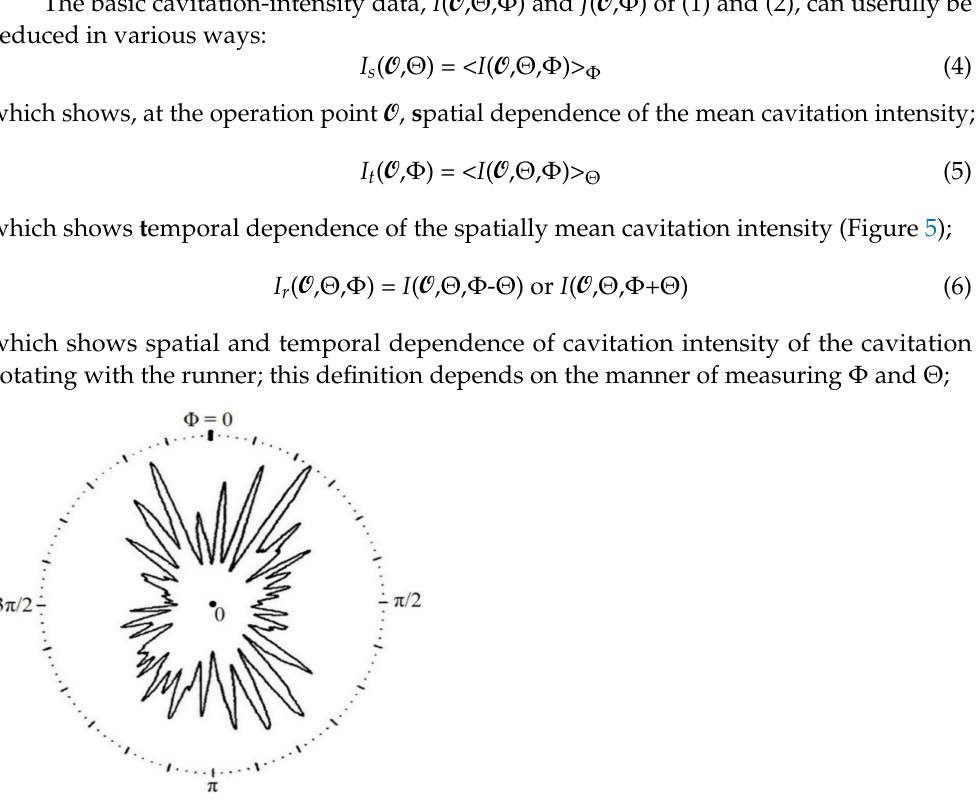
Figure 3. Front panel of the multidimensional data acquisition processor. The simplest description of cavitation comes out online after half an hour of measurement on the prototype. More compli- cated descriptions require days or weeks of recorded data analysis by a trained user.